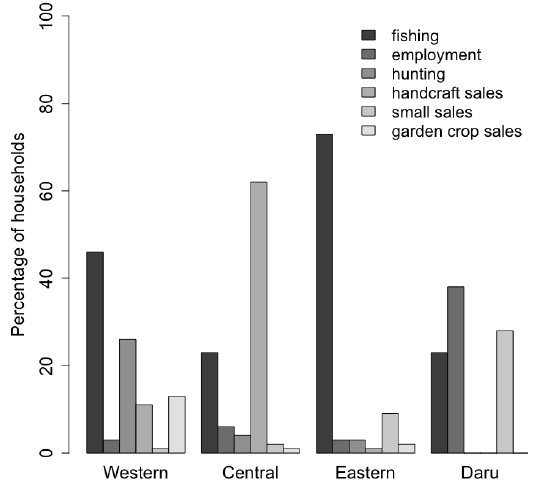
Fig. 3 . Sources of income in the village clusters as a proportion of household questionnaire responses. Western villages are Bula, Jarai, Mari, and Tais; eastern villages are Buzi, Ber, and Sigabaduru; eastern villages are Mabudauan, Mawatta, Tureture, Kadawa, Katatai, Parama, and Sui.